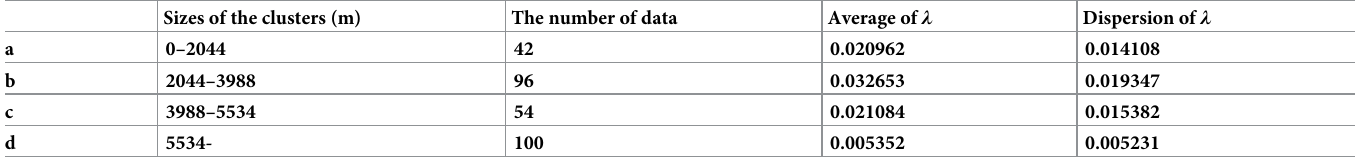
Table 1 shows the mean and standard deviation of λ for each cluster region. This table expresses that the mean and standard deviation of λ for clusters a and c are almost the same. The mean and standard deviation of b between a and c are higher than those of a and